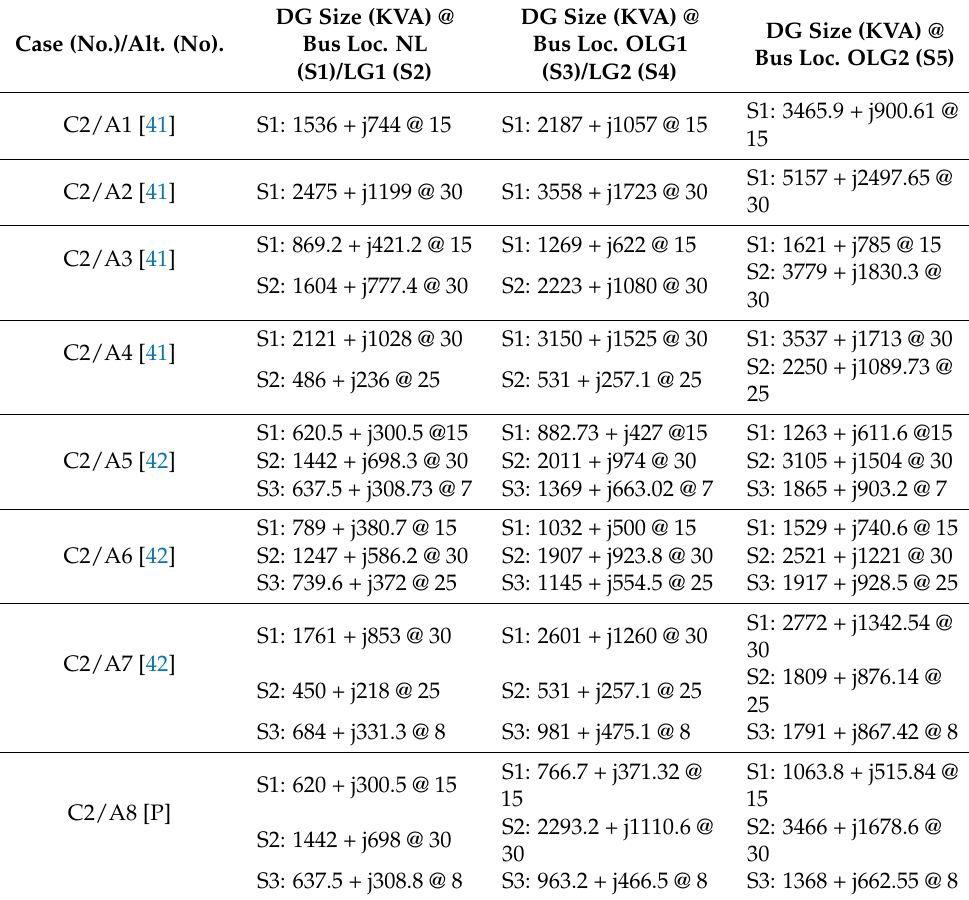
Table 10. REG and D-STATCOM set (sitting and sizing) generating power equal to DG at 0.9 LPF for C2/S1–S5 across respective